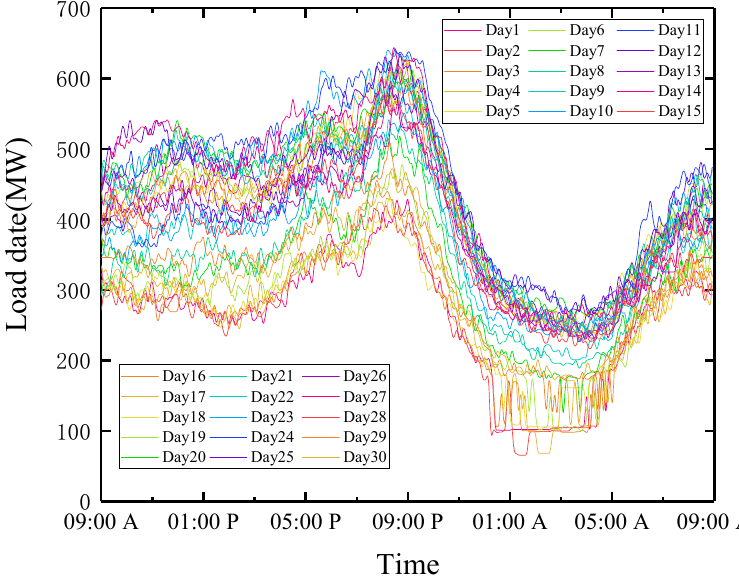
Figure 4. FTU that measures the 30-day active power daily load curve.